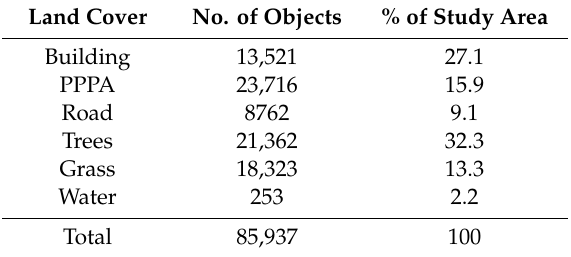
Table 5. Summary of segmentation / classification results.